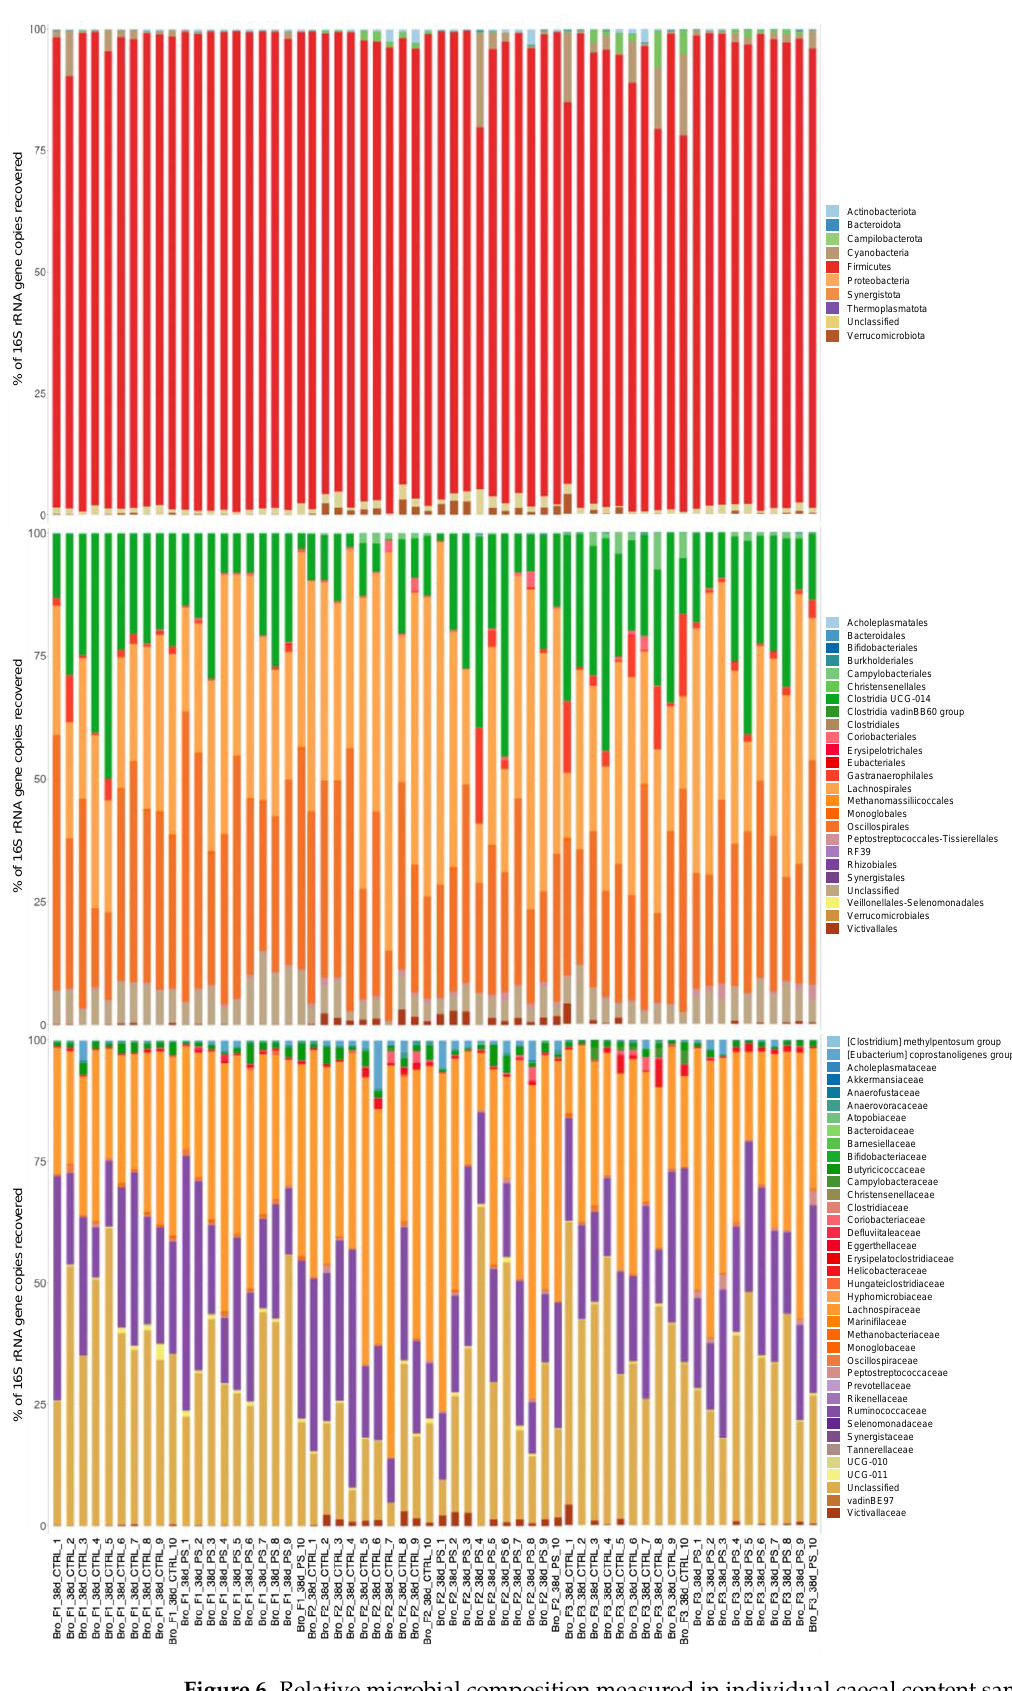
Figure 6. Relative microbial composition measured in individual caecal content samples, shown at Phylum ( top ), Order ( centre ) and Family ( bottom ) level.